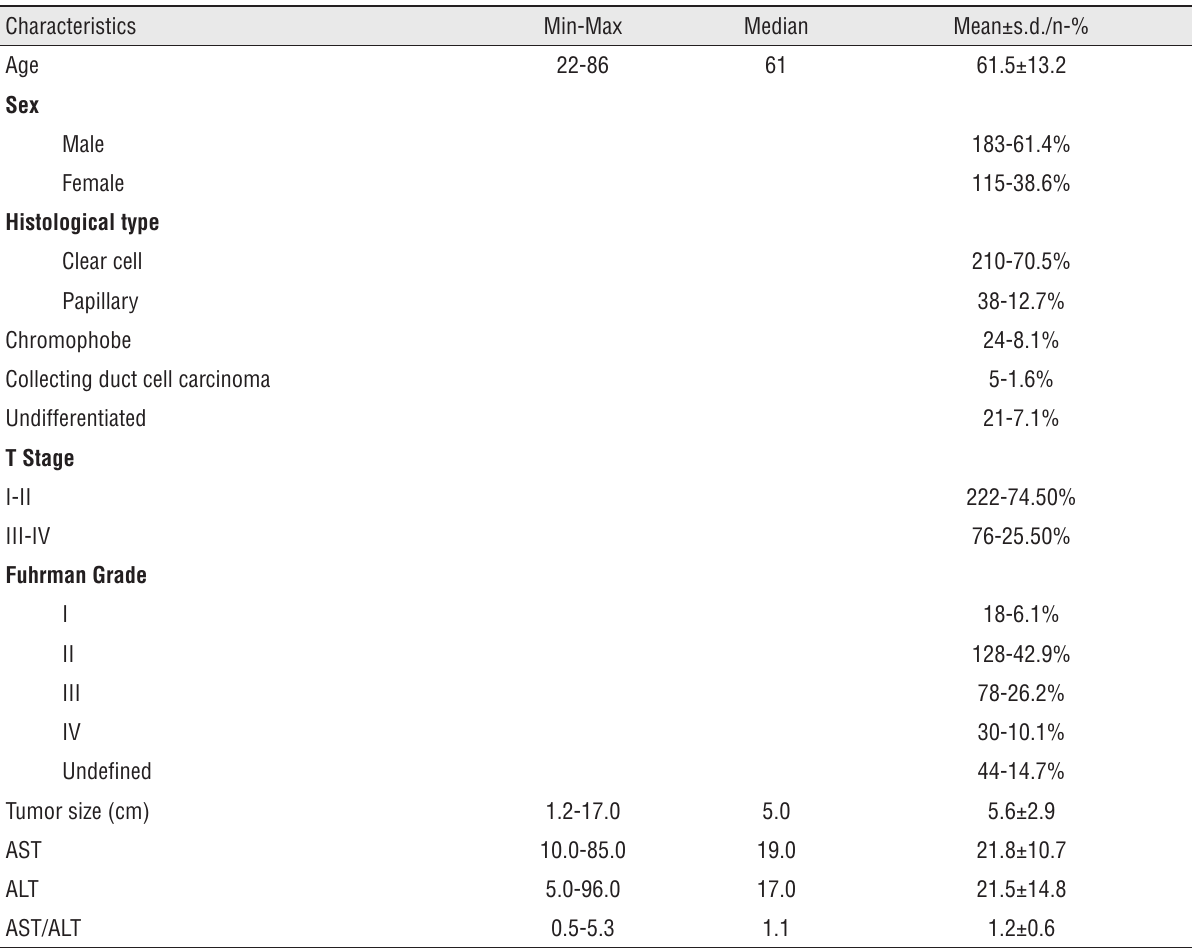
Table 1 - Clinicopathological characteristics of patients.